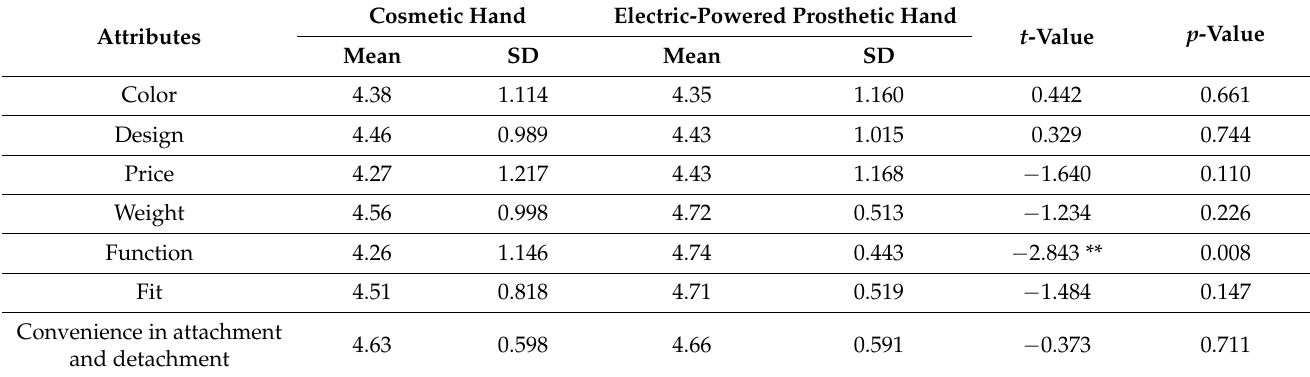
Table 7. Consumer’s priorities for cosmetic hand and electric-powered prosthetic hand ( n =